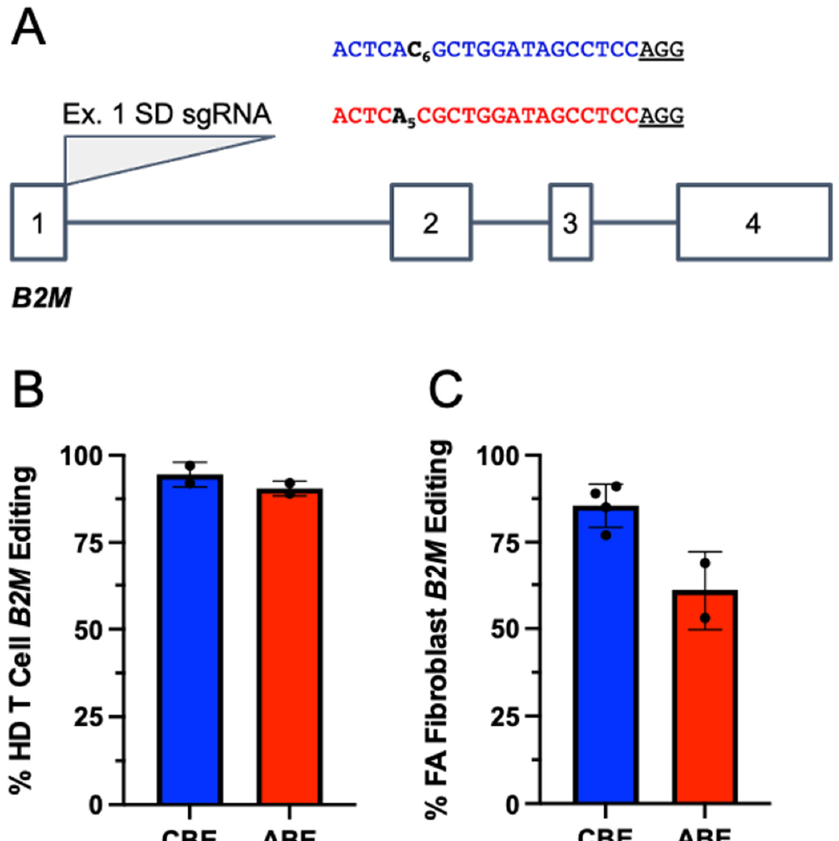
Figure 2. Base editors are highly functional in FA cells. ( A ) Diagram of the B2M genetic locus showing the four exons and three introns. Immediately following exon 1, a SD site was targeted with a sgRNA (gray triangle) in combination with CBE or ABE mRNA which causes protein KO. The sgRNA is depicted in blue showing the target C base when using CBE and in red showing the target A base when using ABE. ( B ) HD T cells were electroporated using the sgRNA shown above in combination with CBE or ABE mRNA with the Amaxa system. Data are represented as mean ± SD with n = 2 replicates. ( C ) FA fibroblasts were electroporated using the sgRNA shown above in combination with CBE or ABE mRNA with the Amaxa system. Data are represented as mean ± SD with n = 2 or n = 4 replicates.